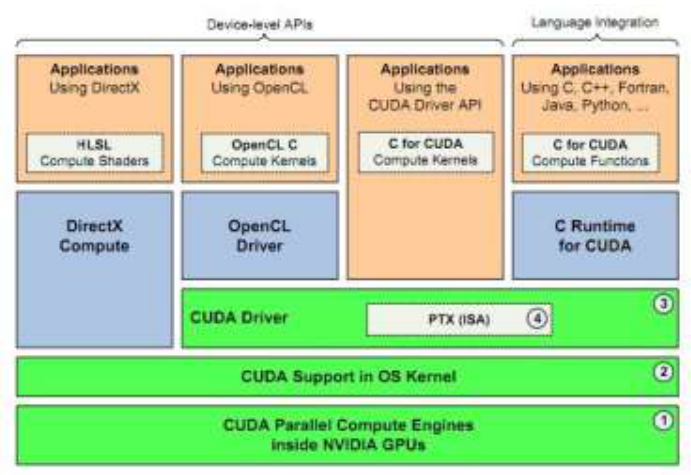
Figure 3. Software architecture of CUDA